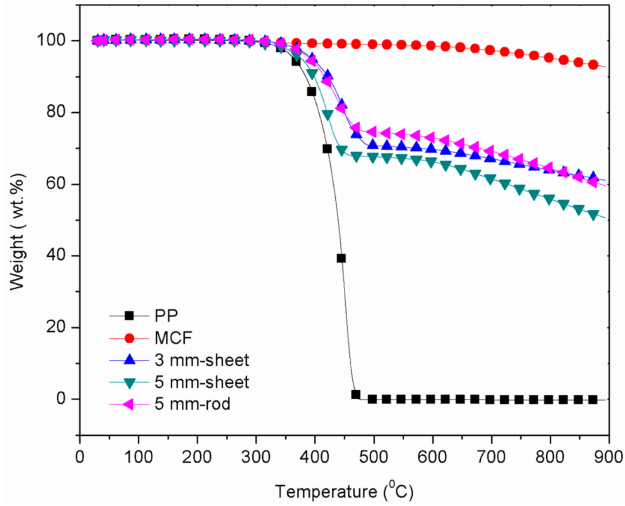
Figure 2. TGA curve of MCF/PP polymer composite at different die